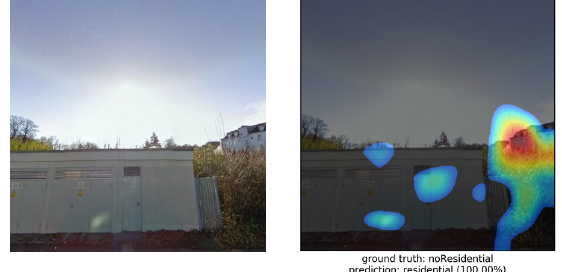
Figure 7. Example of a “false” prediction. Original image ( left ) and original image overlaid by its upsampled CAM ( right ).